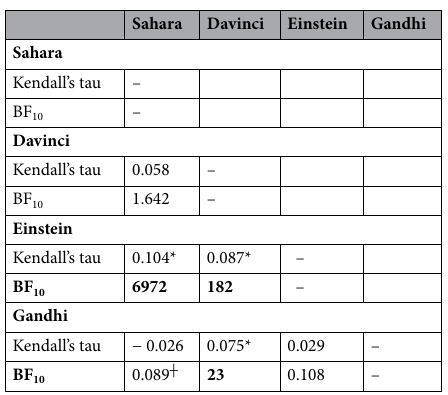
Table 2. Rank intercorrelations using Bayesian Kendall’s Tau. Bold fonts highlight BFs exhibiting at least strong evidence for a relationship. BF 01 indicates evidence in favor of the null hypothesis (H0) and